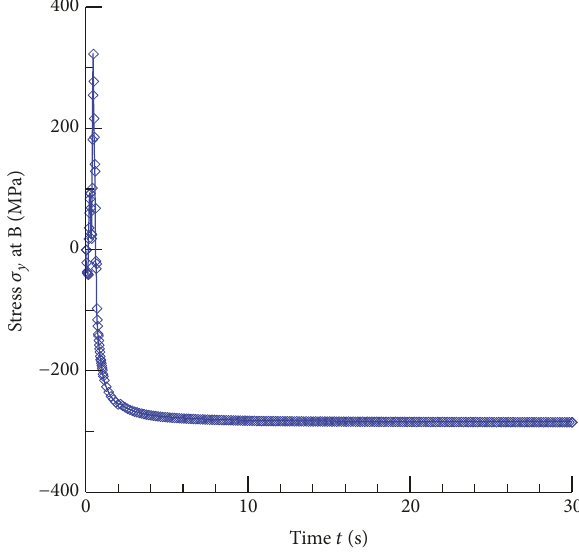
Figure 9: Time-history of stress near crack tip ( 𝑡 = 0 ∼ 30s).